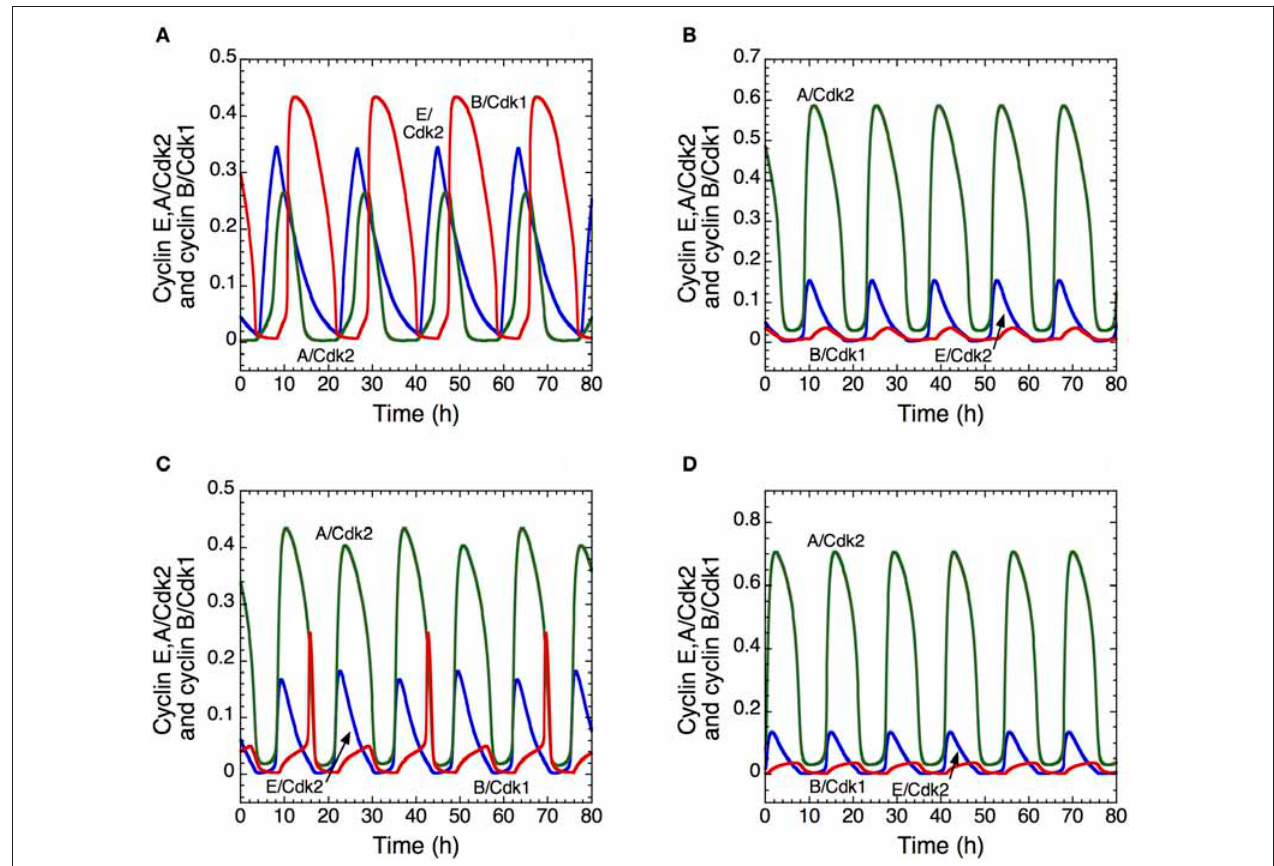
FIGURE 7 | Endoreplication or tetraploidy in the detailed model for the mammalian cell cycle. The curves show the time evolution of cyclin E/Cdk2 (in blue), cyclin A/Cdk2 (in green) and cyclin B/Cdk1 (in red) corresponding to the “classical” mitotic cell cycle in (A) , to endoreplication cycles in (B) and (D) ; and to tetraploidy in (C) . In (B) , the rate of inhibition of Cdh1, V 2cdh1 ,